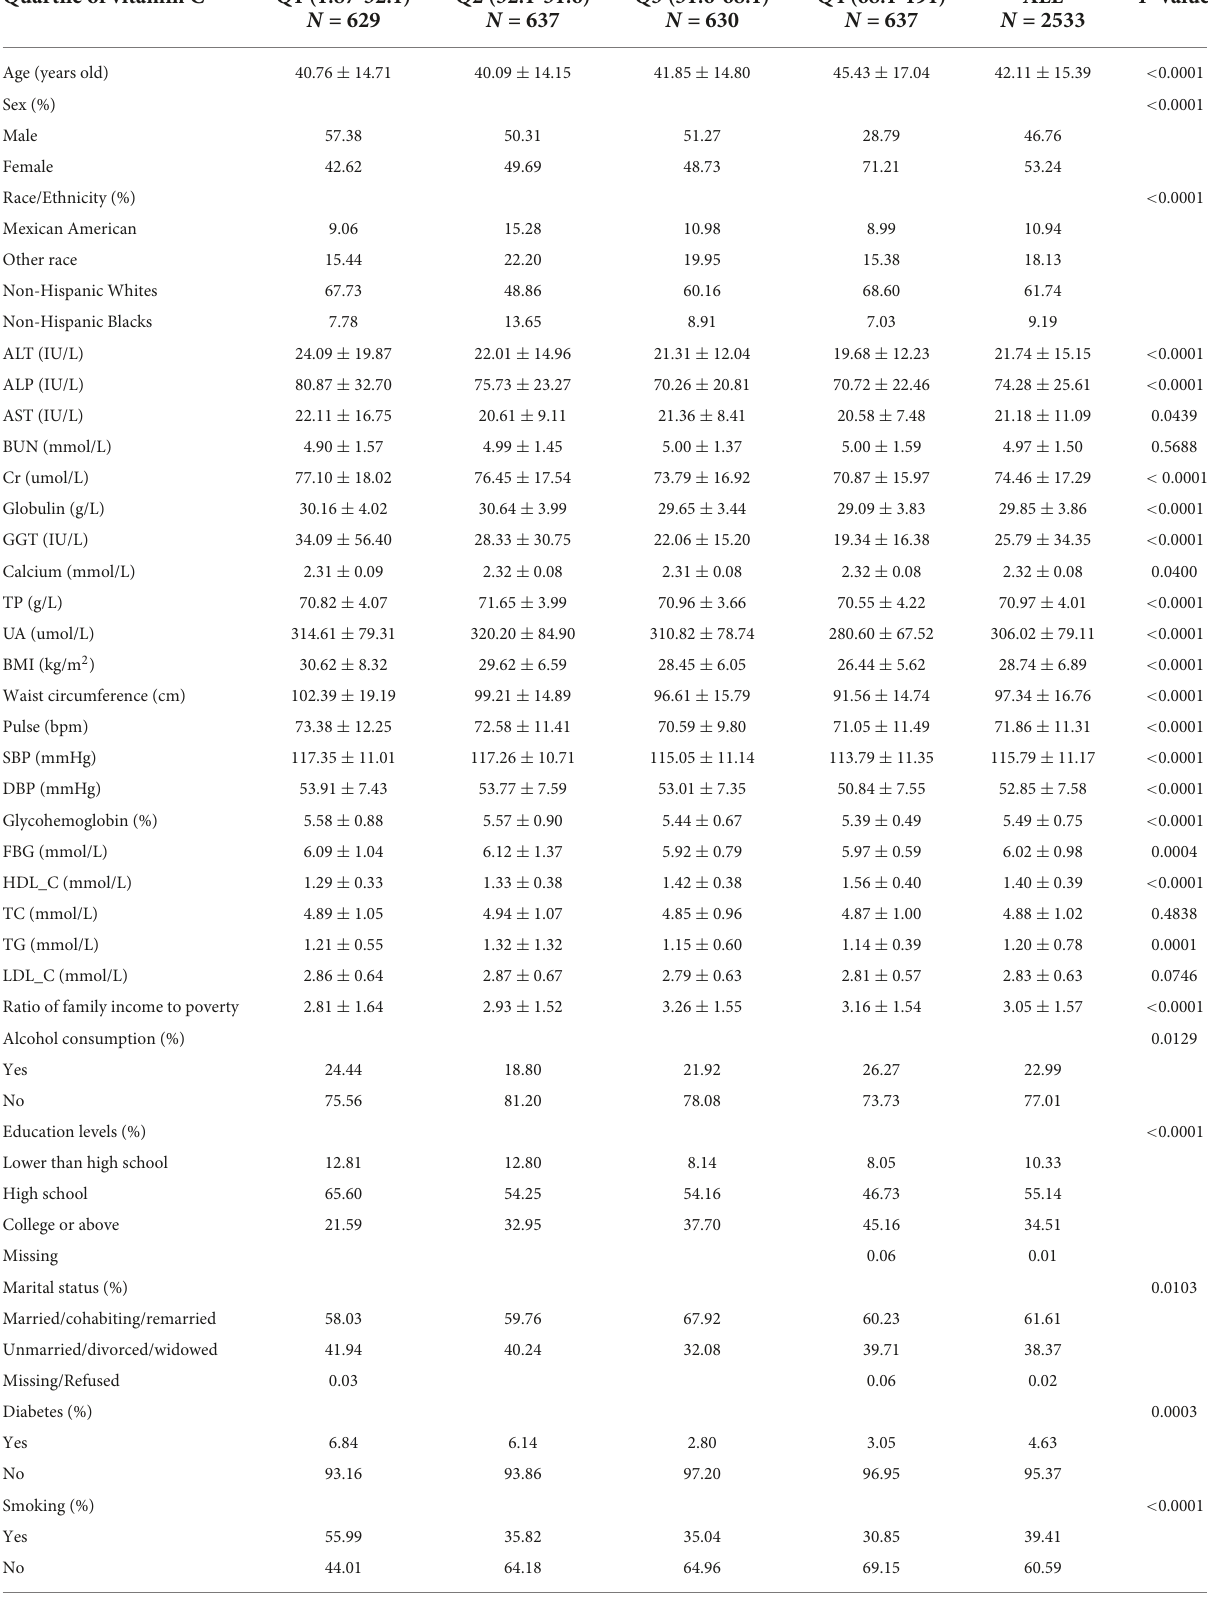
TABLE 1 Description of the participants included in the